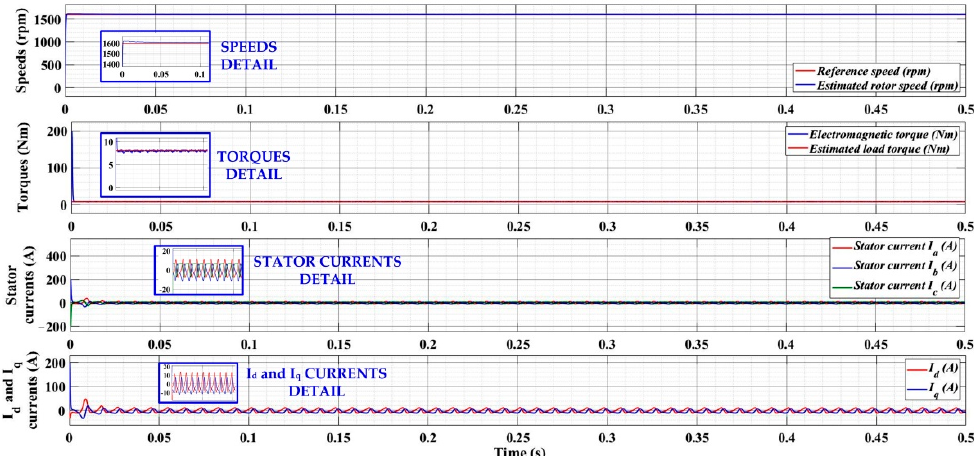
Figure 23. Time evolution for the numerical simulation of the PMSM control system based on the backstepping-PSO controller: ω ref = 1600 rpm, T L = 8 Nm with a uniform random noise, K ω = 0.01, K I ω = 140, K q = 5000, K Iq = 50, γ = 0.01, K d = 300, K id = 300, and 100% increase in J parameter and stator resistance R s